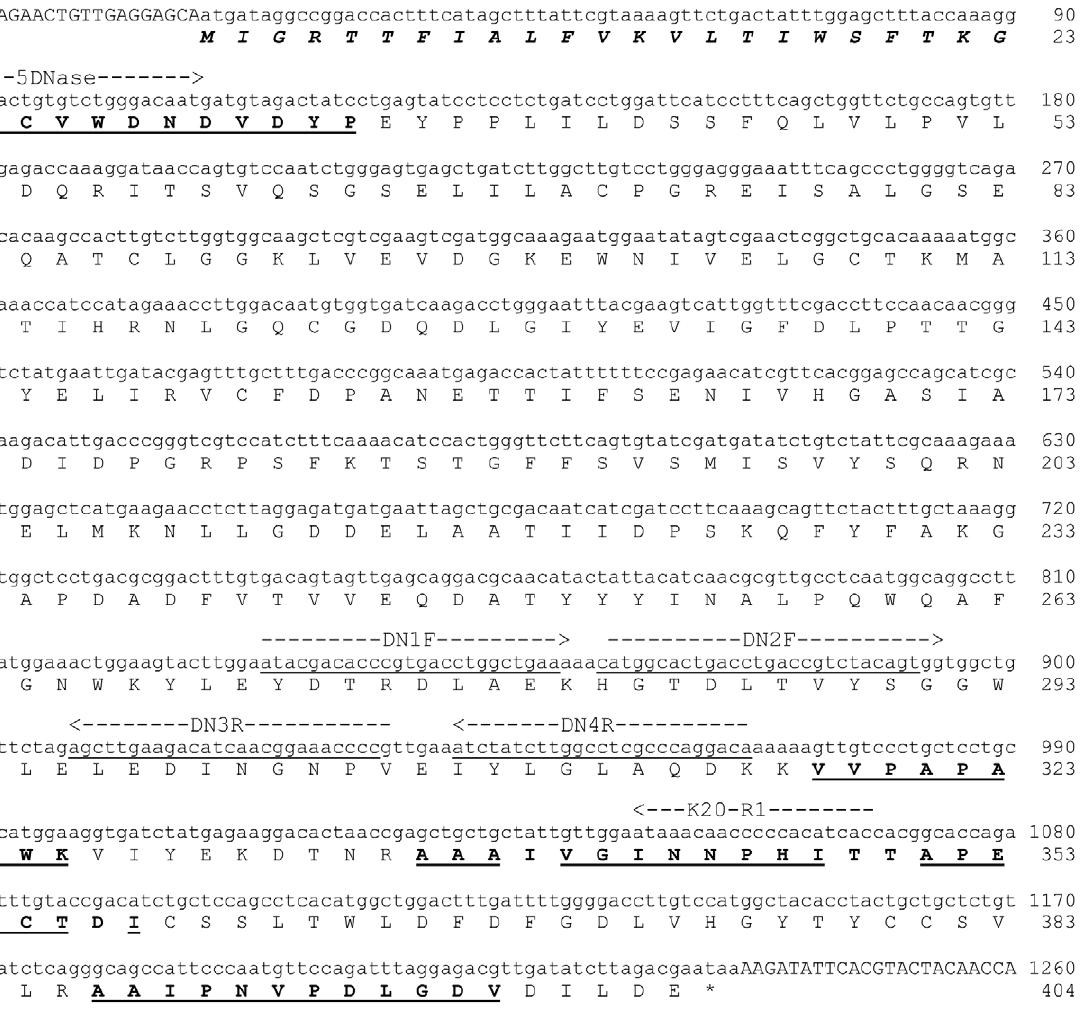
Figure 6. cDNA and amino acid sequence of Northern shrimp dsDNase. Coding sequence is shown in lower letter cases with the derived protein sequence below. A predicted protein signal sequence is highlighted in italics. Location of native protein fragments sequences and their sequence identities compared to cDNA-derived amino acid residues are highlighted and underlined, respectively. Primers used for amplification reactions are indicated above their corresponding cDNA sequence. (GenBank accession no.